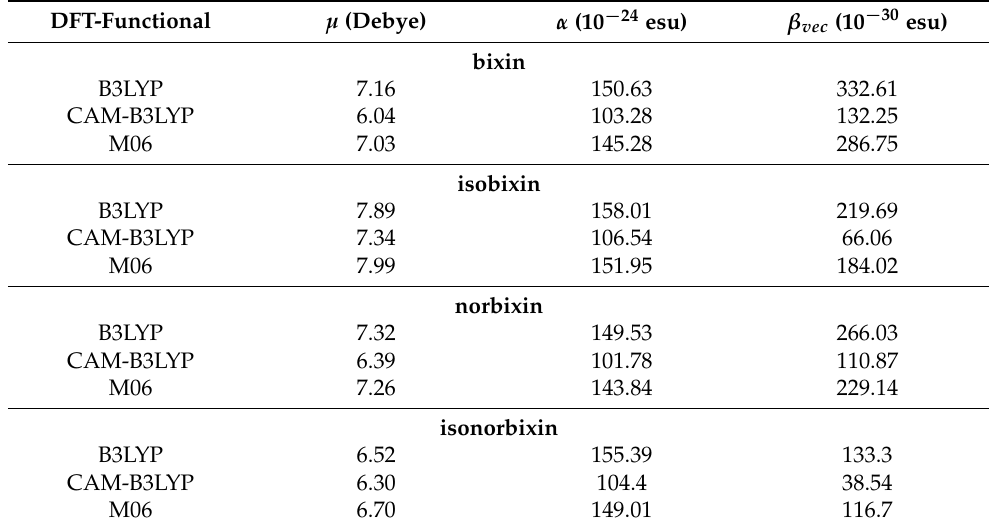
Table A14. Dipole moment ( µ ), average linear polarizability ( α ), and vector component of the first ( β vec ) hyperpolarizability of the dyes in chloroform solution. These results were obtained by employing the 6-31G basis set.